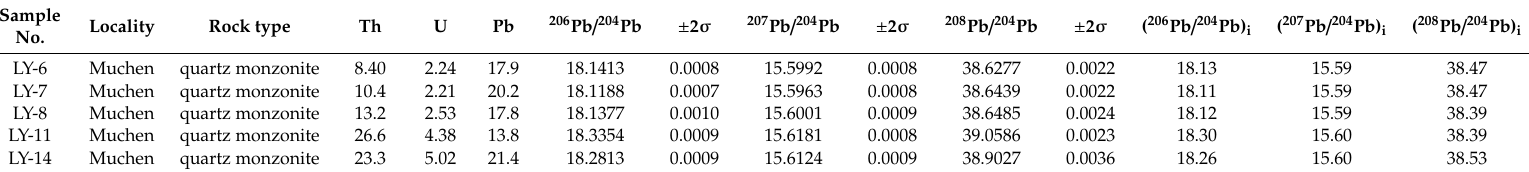
Table 2. Pb Isotopic Data for Muchen Pluton.